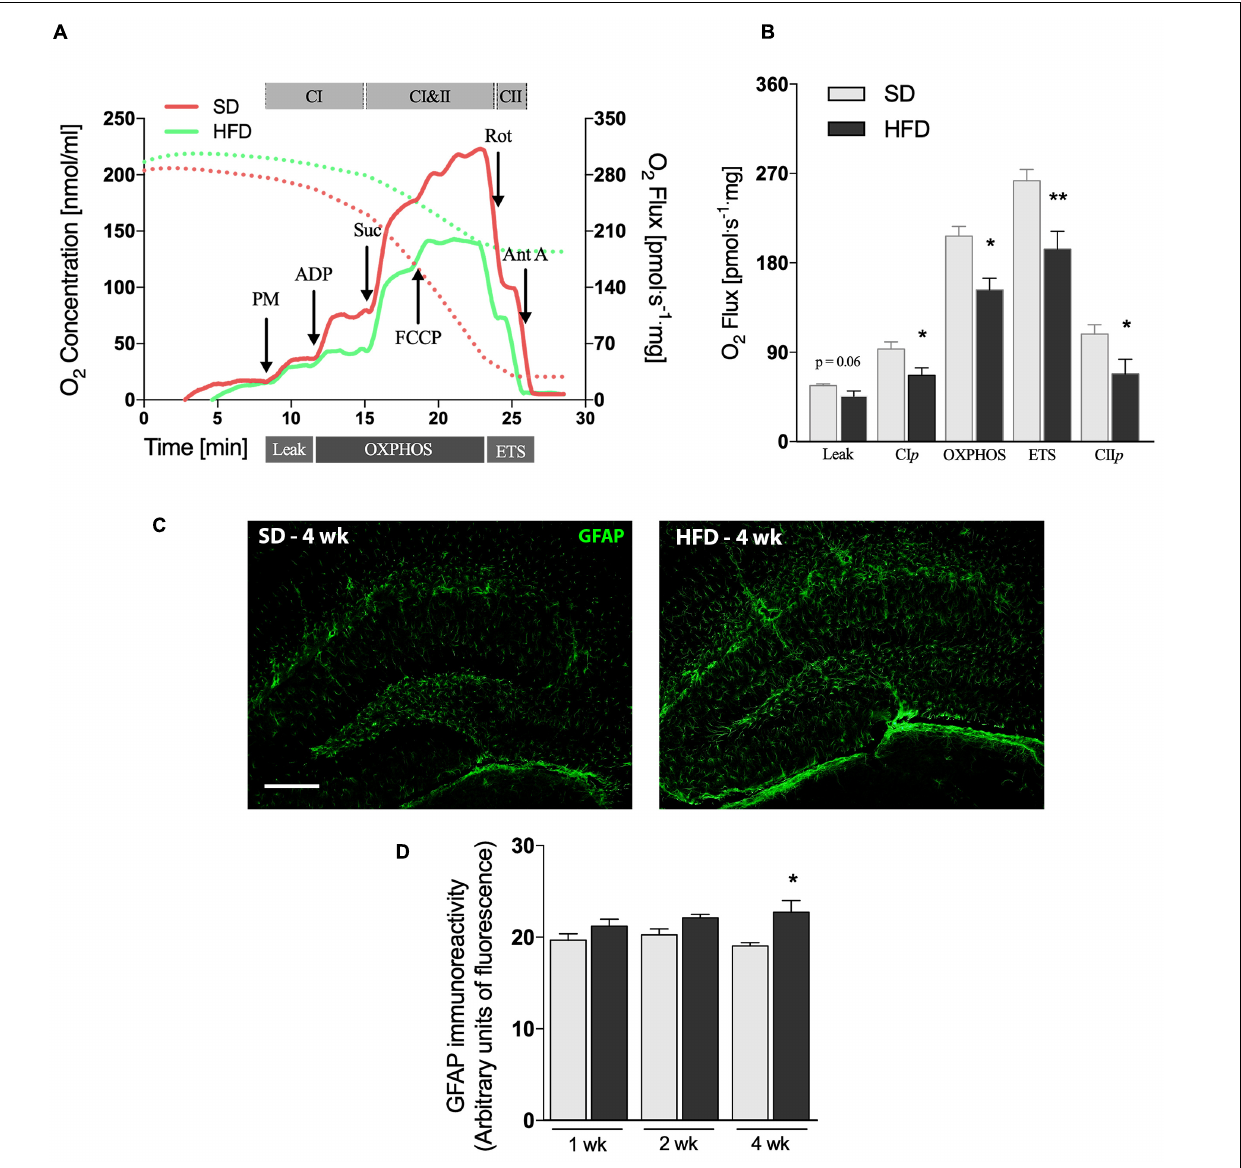
FIGURE 2 | Hippocampal alterations followed by 4 weeks of HFD. (A) Representative experiment in SUIT protocol. (B) Respirometric measurements by oxygen flux using PM as initial substrates (leak), followed by ADP (CI p ), S (Oxphos), FCCP titrations (ETS), and finally inhibited by Rot (CII p ; F = 2.077) and Ant A in the hippocampus of mice submitted to 4 weeks of SD or HFD ( n = 5–6). (C) Representative images of GFAP immunolabeling in the hippocampus of 4 weeks SD and HFD-fed mice (scale bar = 150 µ m) along with (D) quantification of GFAP immunoreactivity ( n = 4). Values are mean ± SEM. Unpaired t -test performed. * p < 0.05, ** p < 0.01 SD vs.